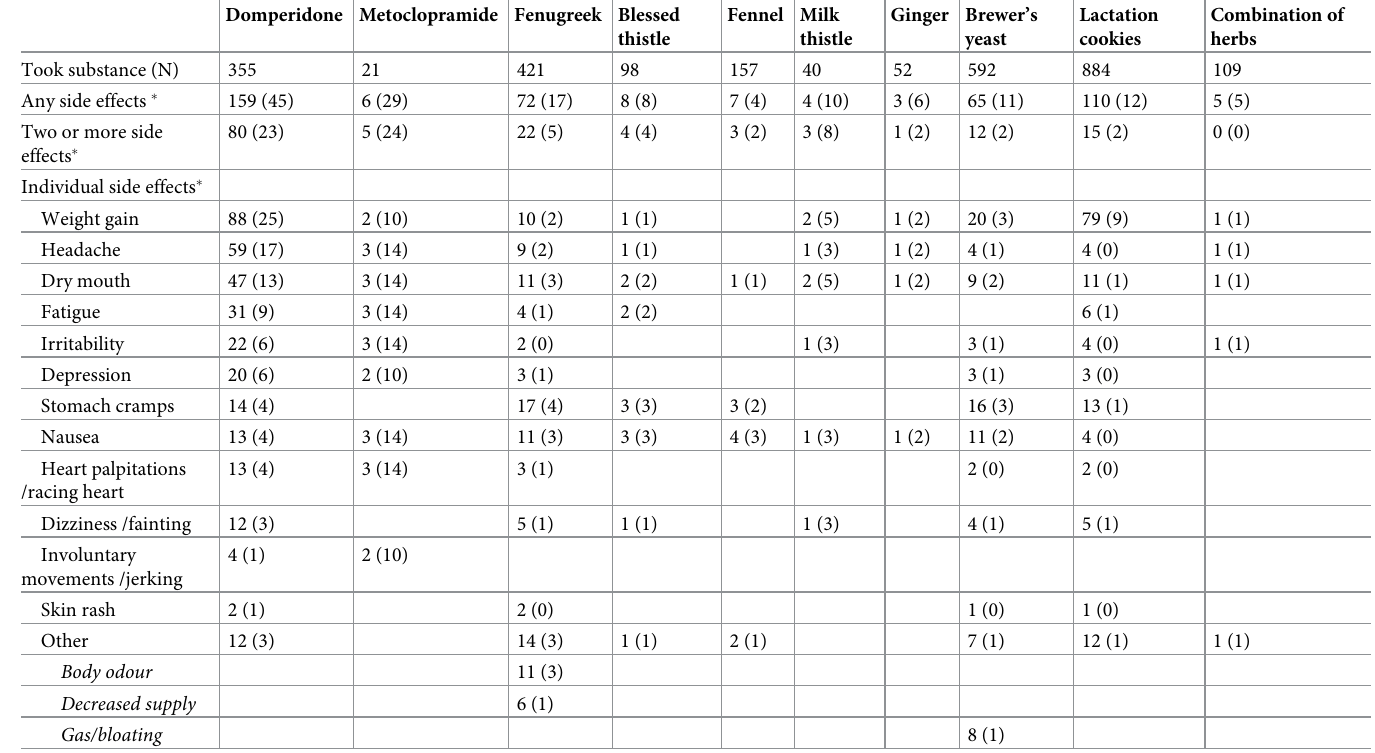
Table 3. Self-reported side effects for galactagogues used by breastfeeding women (n = 1120). Domperidone Metoclopramide Fenugreek Blessed